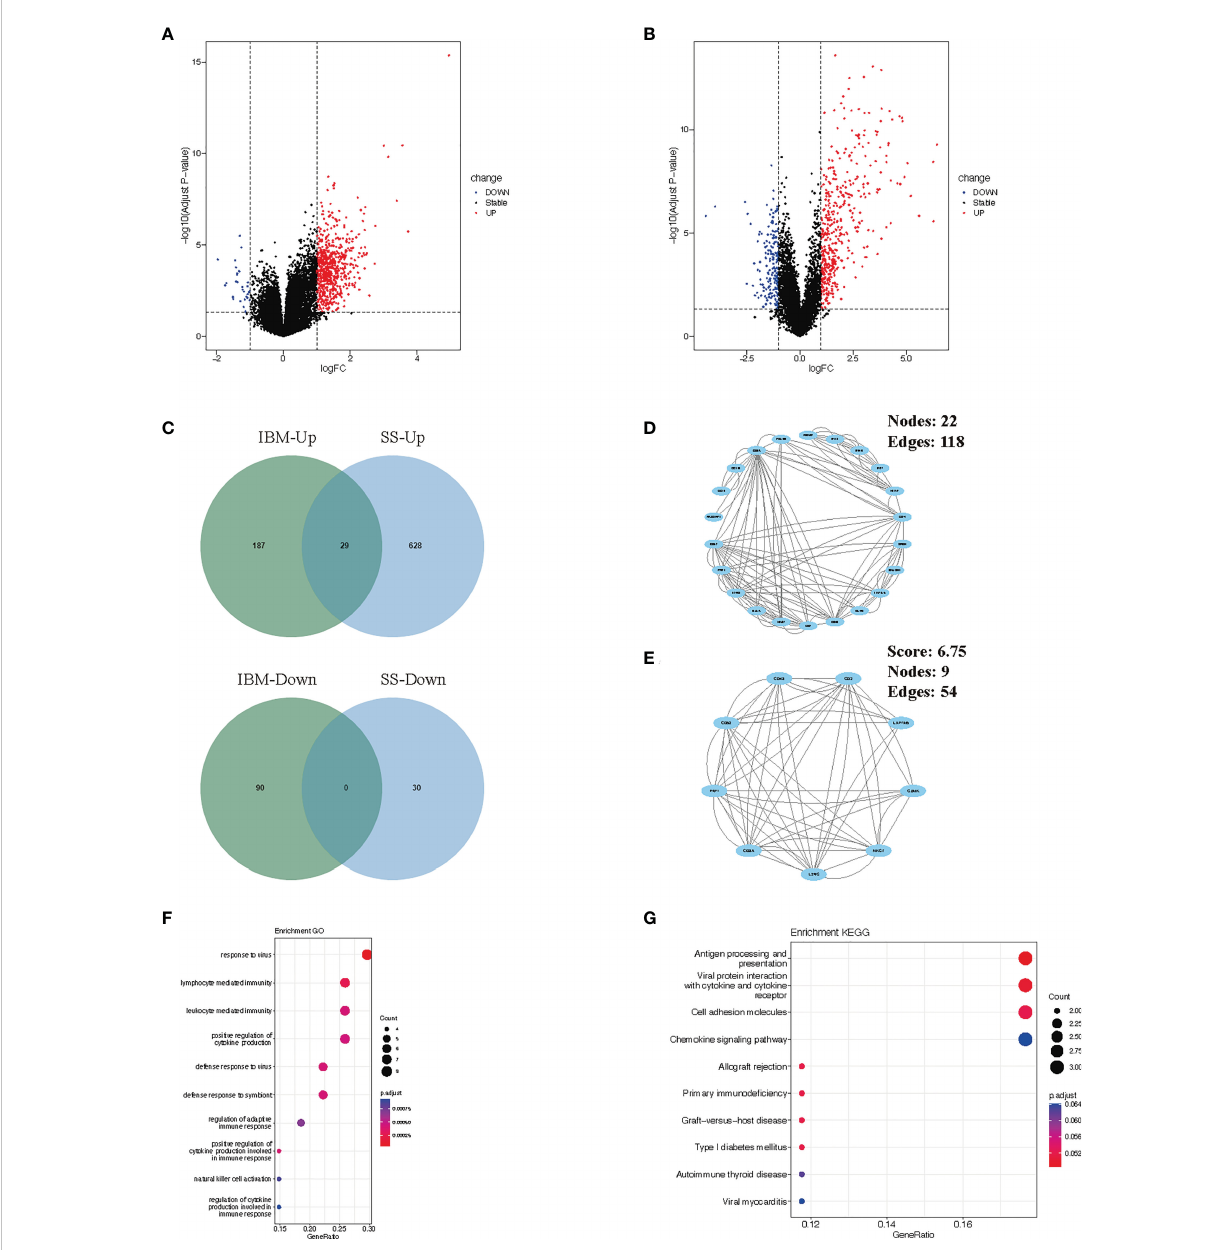
FIGURE 3 Veri fi cation and analysis of shared DEGs in SS and IBM. (A) Volcano plots of the DEGs in SS. (B) Volcano plots of the DEGs in IBM. (C) Venn diagram for shared DEGs in the GSE173808 and GSE128470 datasets. (D) The PPI network of the shared DEGs. (E) One cluster extracted by the MCODE plug-in. (F) GO enrichment results of shared DEGs. (G) KEGG enrichment pathways of shared genes. DEGs, differentially expressed genes; SS, Sjögren syndrome; IBM, inclusion body myositis. PPI, protein − protein interaction; MCODE, Minimal Common Oncology Data Elements; GO, Gene Ontology; KEGG, Kyoto Encyclopedia of Genes and